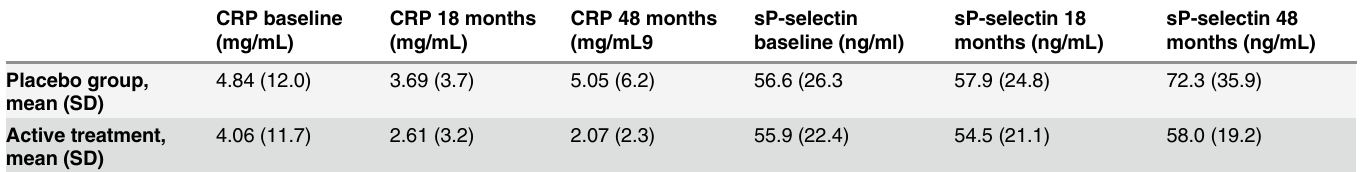
Table 2. Levels of C-reactive protein and sP-selectin at study start, after 18 months and at study end in the placebo group, and in the active treat- ment group.